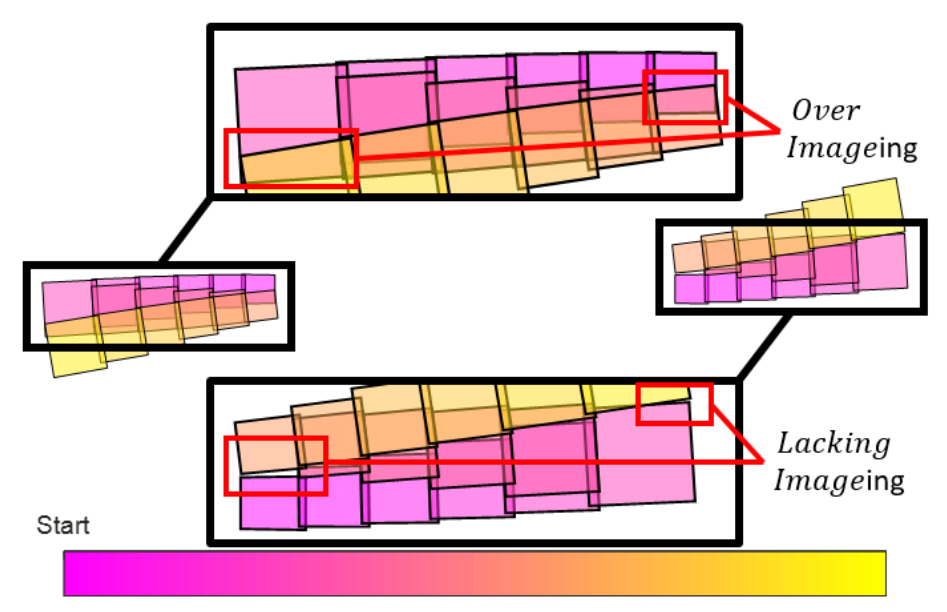
Figure 15. Image overlay diagram of the vertical rail direction.